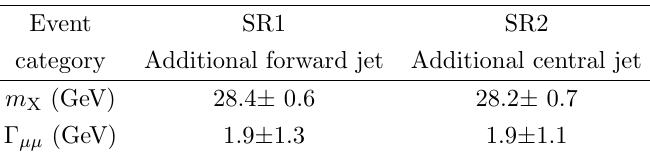
Figure 2 . Upper row: the 12 < m (cid:22)(cid:22) < 70 GeV range in SR1 (left) and SR2 (right) in the 8 TeV analysis. Lower row: the 12 < m (cid:22)(cid:22) < 70 GeV range in SR1 (left) and SR2 (right) in the 13 TeV analysis. The results of an unbinned maximum likelihood (cid:12)t for the signal-plus-background (solid lines) and background-only (dashed lines) hypotheses are superimposed.